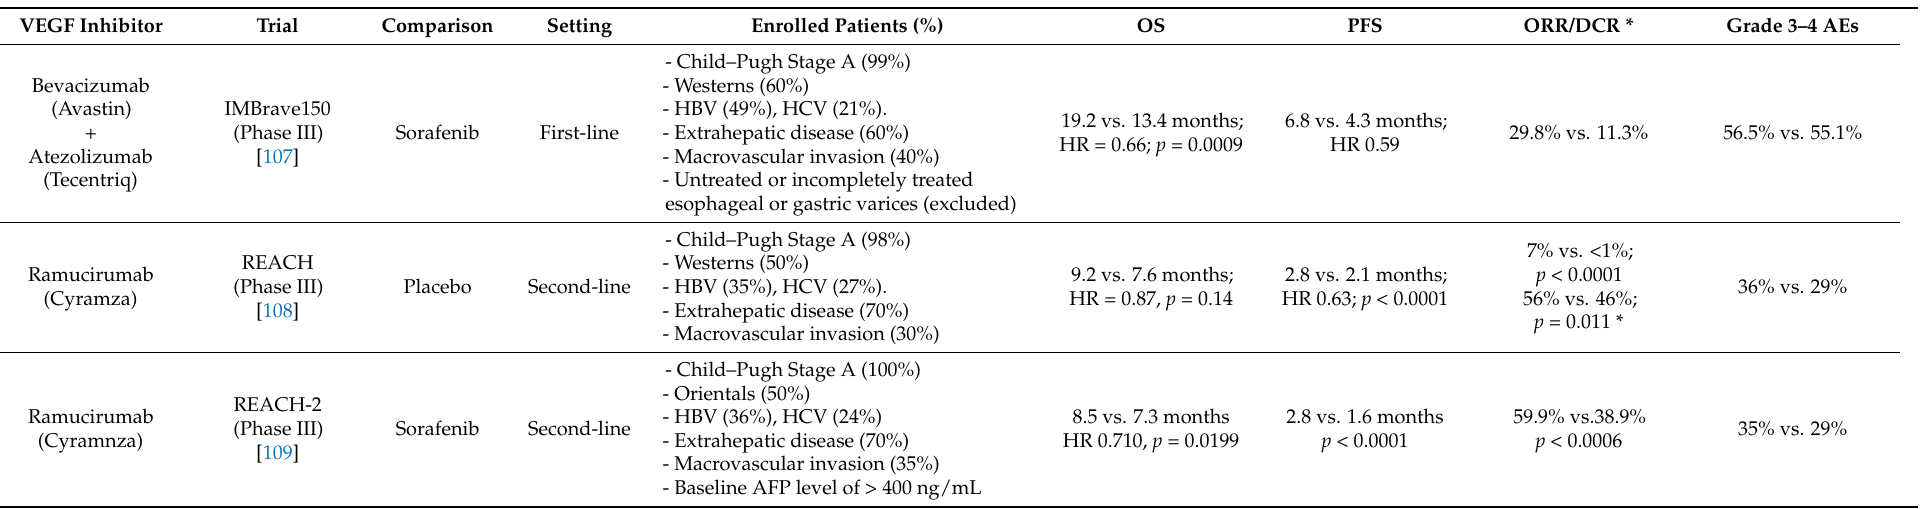
Table 2. VEGF Inhibitors for treatment of advanced